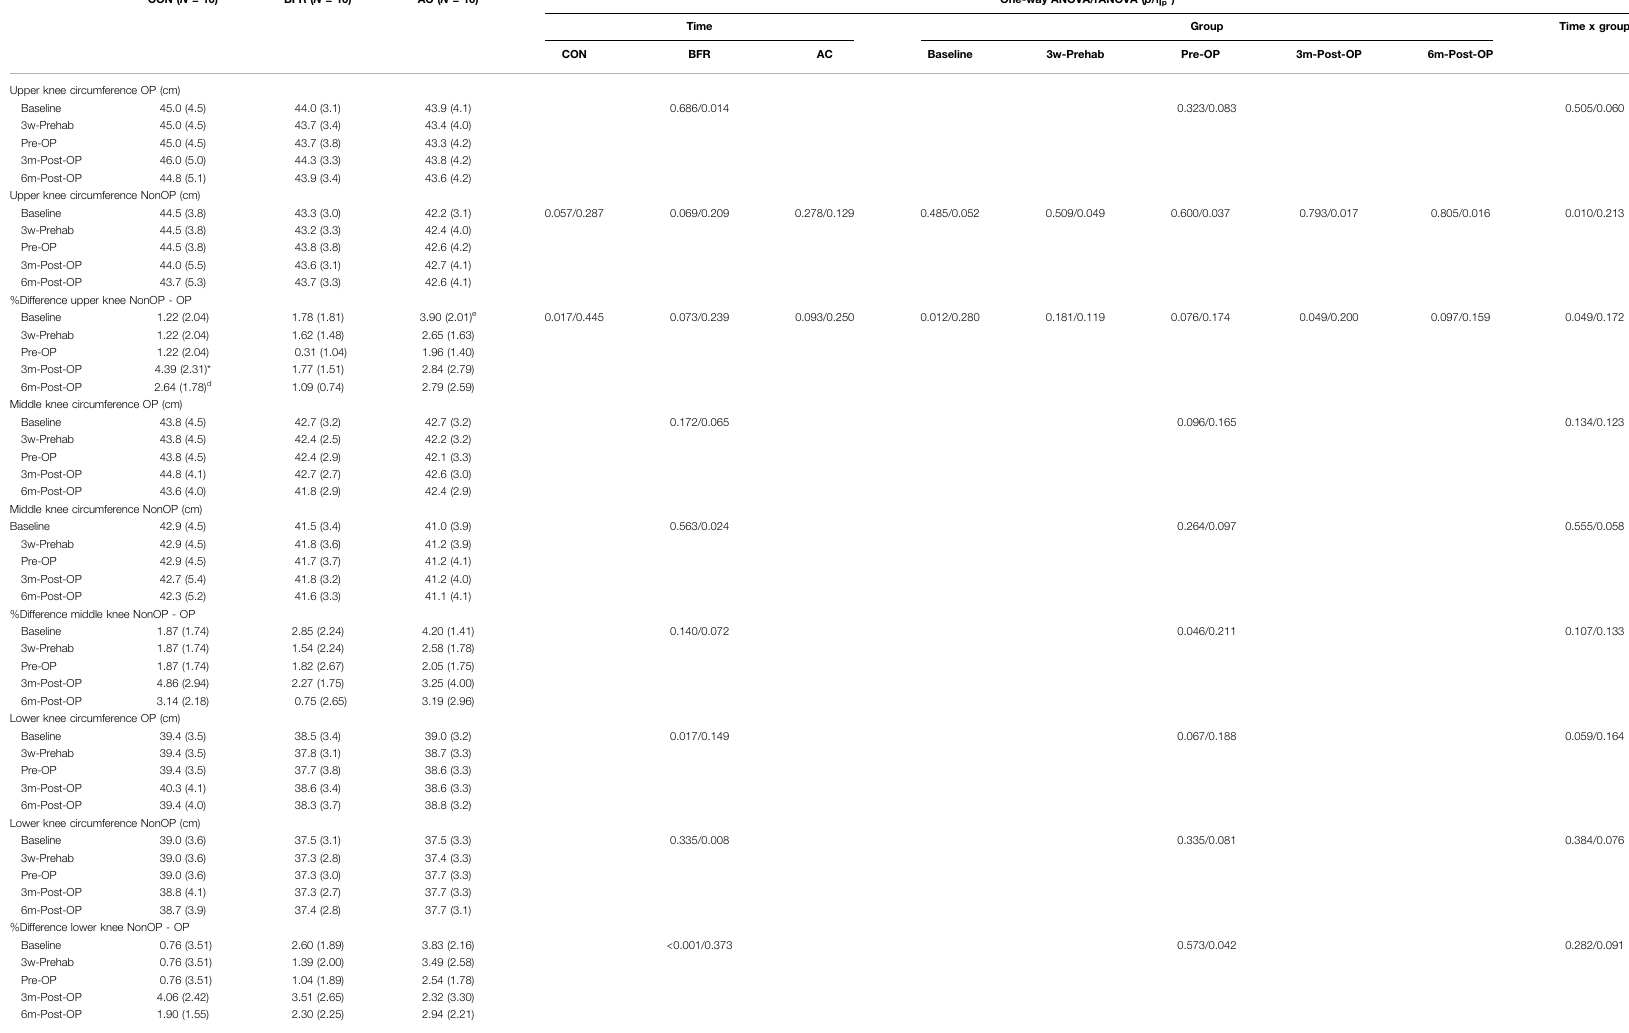
TABLE 4 | Measures related to knee swelling during the prehabilitation- and post-operative